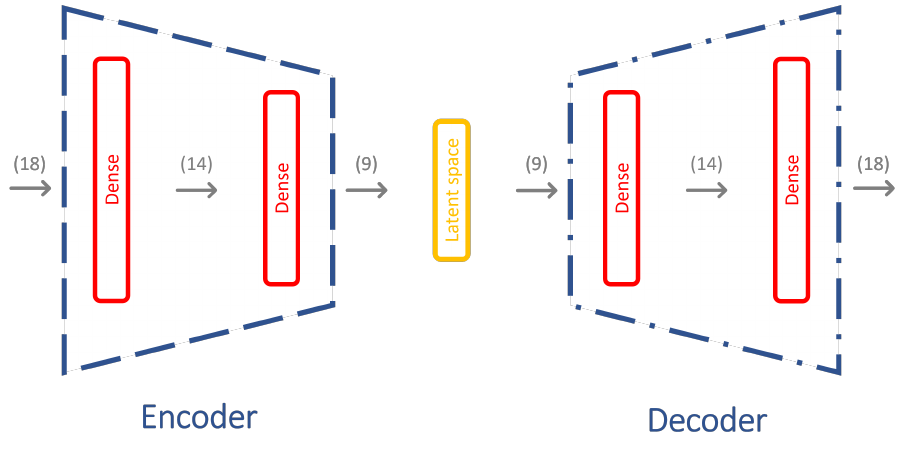
Figure 7. Autoencoder’s architecture.